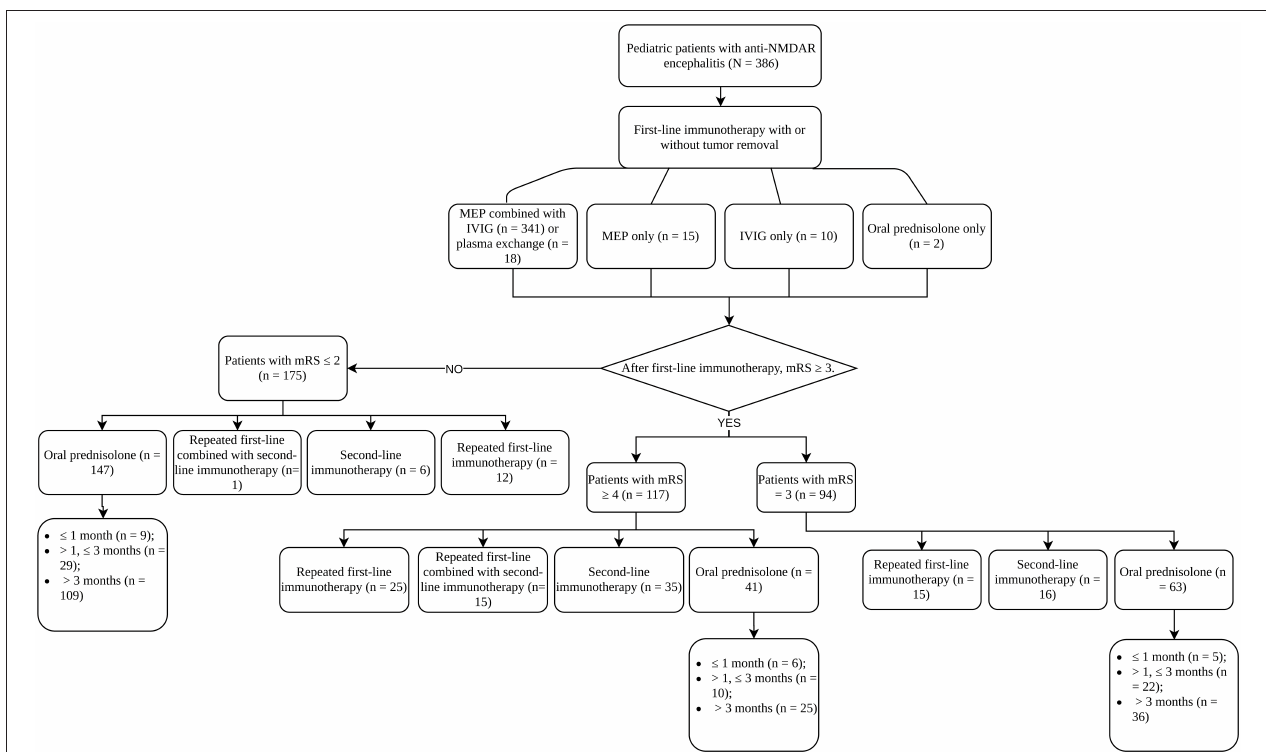
FIGURE 1 | Treatment strategies of patients with anti-NDMAR